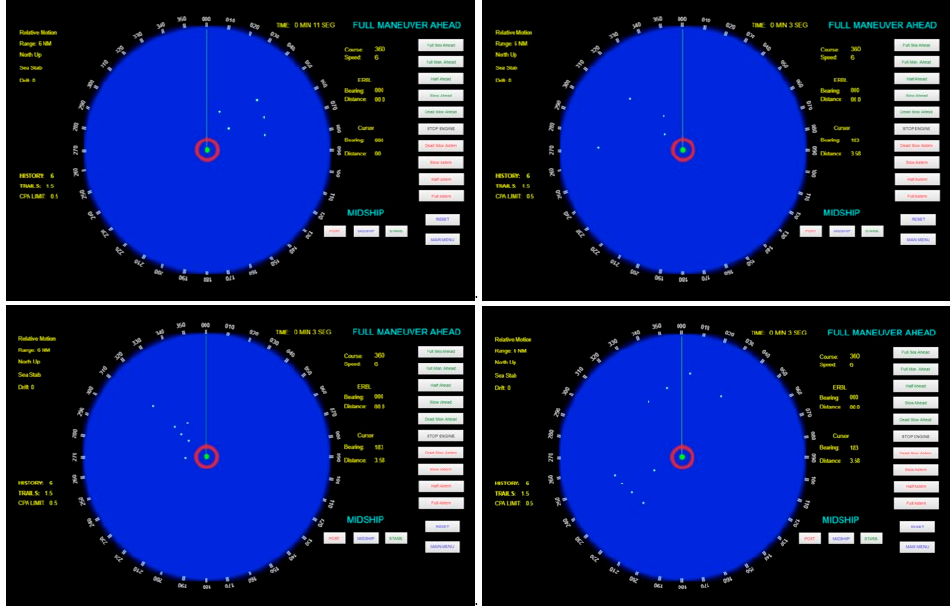
Figure 10. Examples of real negative cases where the attack command is not displayed in the PPI. Five threshold levels σ were assessed: 0.3, 0.4, 0.5, 0.6, 0.7. Recall that the computed PCCs are compared with the threshold levels in order to decide if a match was found or not (see Section 3). Each threshold level was assessed using the set of 30 different scenarios. The confusion matrices and accuracies of each threshold level are compiled in Table 2. The performance rates (in percentages) of the triggering mechanism for each threshold level is depicted in Figure 11 and the obtained receiver operating characteristic (ROC) curve is shown in Figure 12.